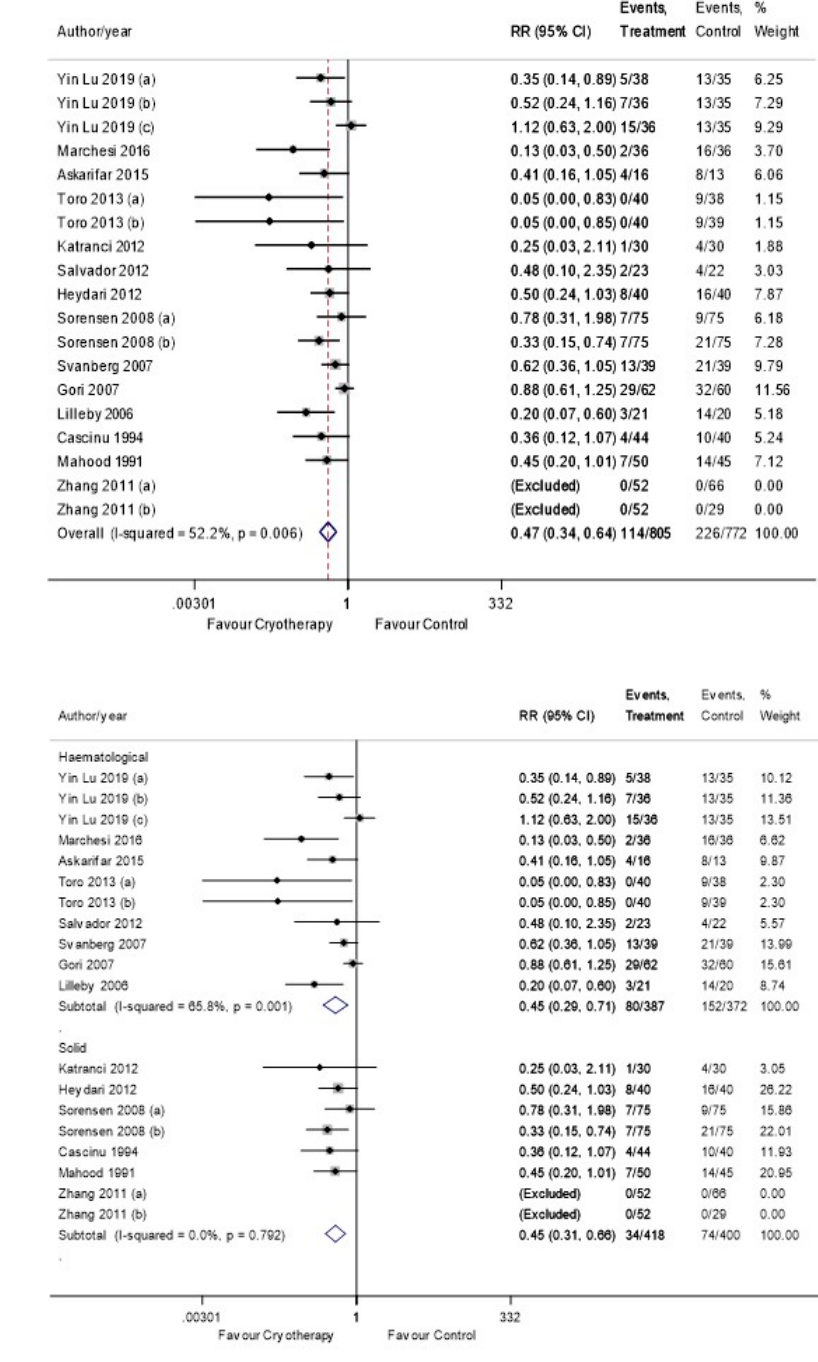
Figure 4. ( a ) Forest plot illustrating the pooled data on the effects of OC on the incidence of OM (severe). ( b ) Forest plot illustrating subgroup analysis of the effects of OC on the incidence of severe OM based on the underlying malignancy.